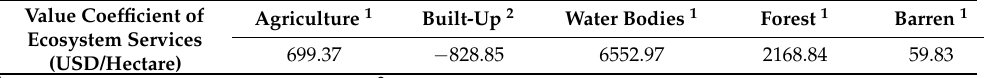
Table 2. The economic value of ecosystem services (in thousands of USD) for different classes covers. Value Coefficient of Ecosystem Services (USD/Hectare)